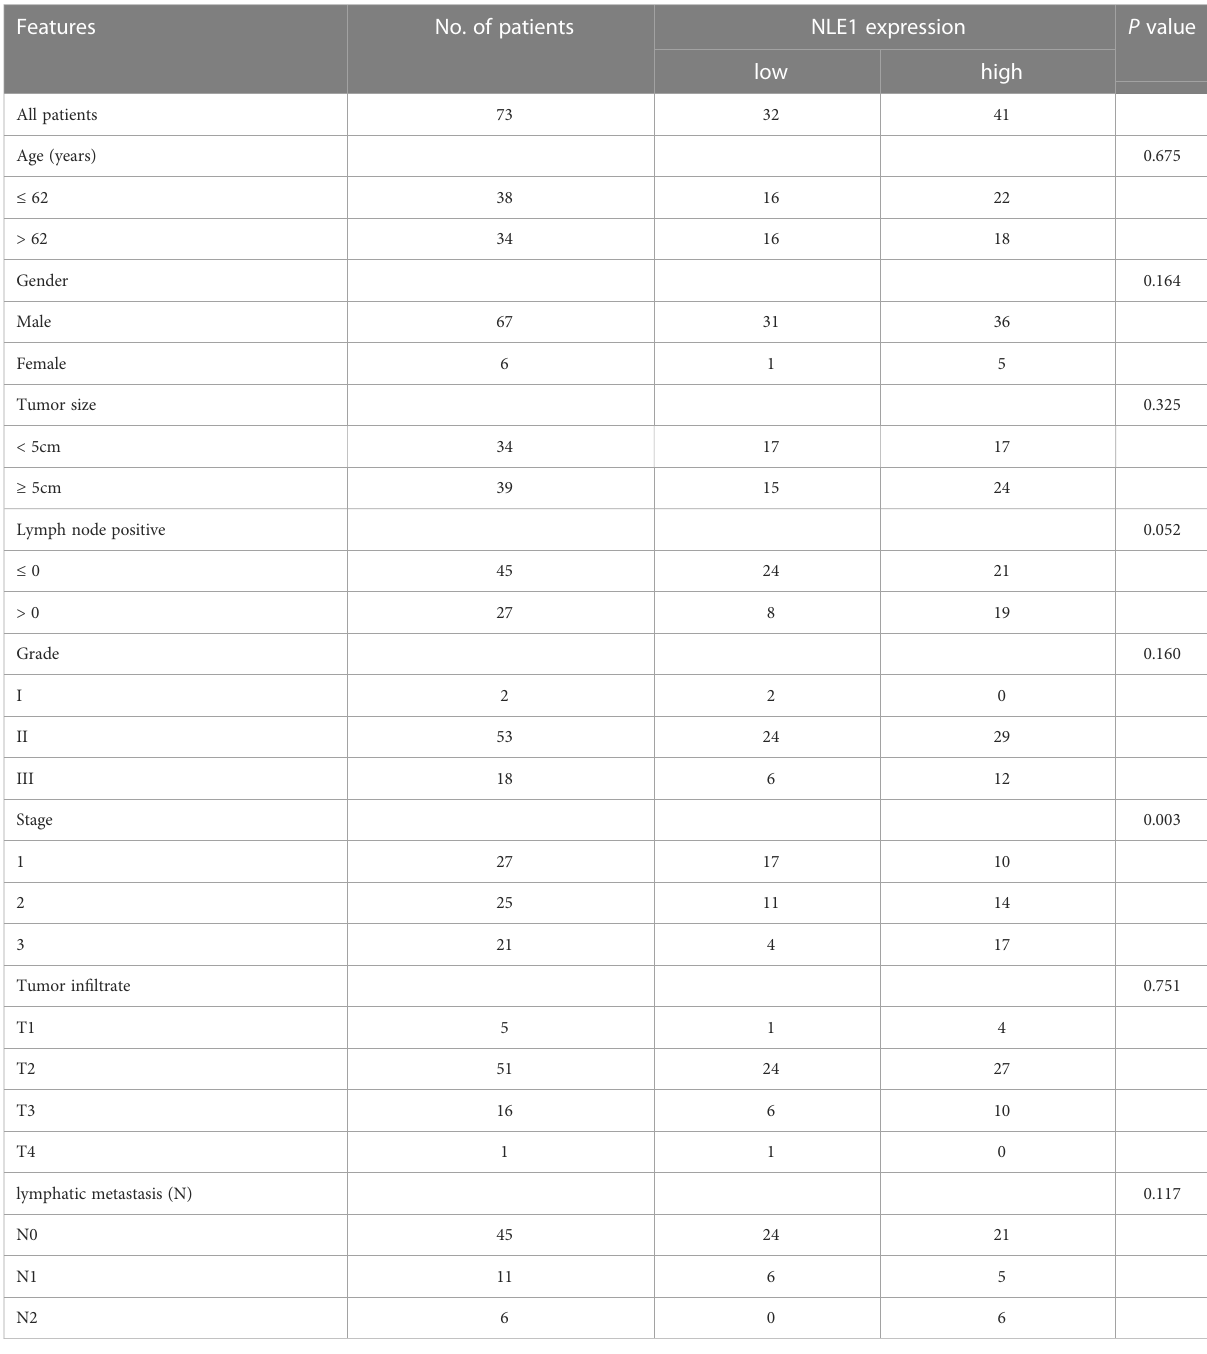
TABLE 2 Relationship between NLE1 expression and tumor characteristics in patients with non-small cell lung